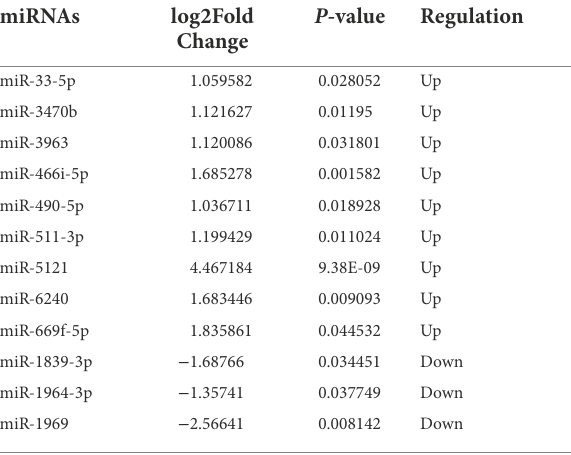
TABLE 3 Information of differentially expressed miRNAs.